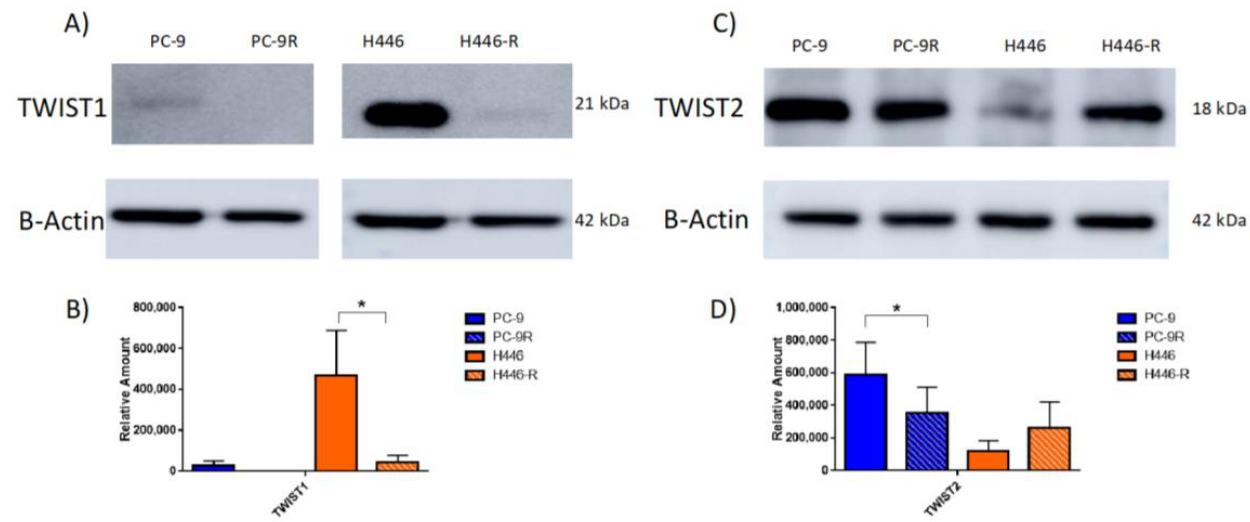
Figure 3. MTI-101-acquired drug-resistant lines demonstrate decreased expression of EMT transcrip- tion factor TWIST at the protein level. ( A ) Western blot probing for TWIST1 in WT and resistant cells; Western blot images were from the same blot but were spliced and rejoined between PC-9R and H446 samples in TWIST1 and β -actin images to remove protein standard marker for clarity. ( B ) Quantifi- cation of Western blot showing significant decreased protein expression of TWIST1 in H446-R cells compared to H446. ( C ) Western blot probing for TWIST2 in WT and resistant cells. ( D ) Quantification of Western blot showing significant decrease in protein expression of TWIST2 in PC-9-resistant cells compared to PC-9 WT. Completed as n = 3 independent experiments with reproducible representative images displayed for Western blots. Error bars represent SEM (significances denoted * for p < 0.05, two-tailed T -test).